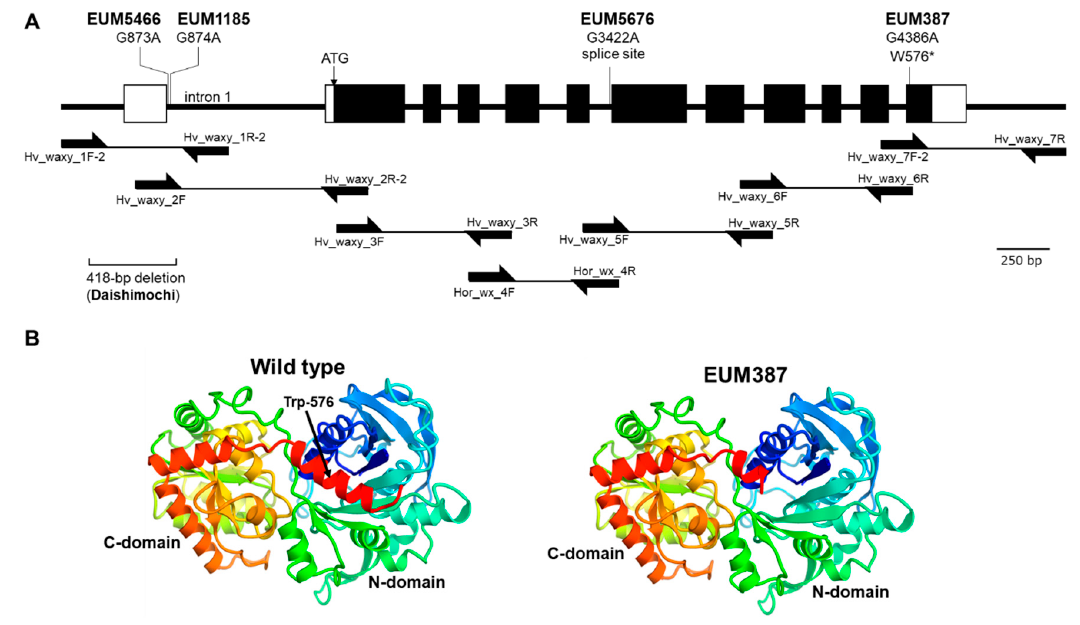
Figure 2. Positions of the identified single nucleotide polymorphisms (SNPs) in the Waxy gene. ( A ) The white and black boxes represent the UTRs and the coding regions, respectively. The nucleotide numbers refer to Domon et al., (2002). The primers and the sequenced PCR amplicons are shown as the arrows and the lines. The positions of SNPs identified from the isolated mutants are shown. EUM5466 and EUM1185 have base substitutions of G873A and G874A in the intron 1, respectively. EUM5676 has a base substitution of G3422A at the 3 ′ splice site of the intron 7. EUM387 has a base substitution of G4386A, which generates a stop codon (*). ‘Daishimochi’ used as a positive control for screening lacks 5 ′ -UTR due to a deletion of 418 bp. ( B ) The barley GBSSI was modeled by Swissmodel using the catalytic domain of rice GBSSIa as a template (PDB ID 3VUF). The C-terminal helix containing Trp-576, which is in close proximity to the N-domain comprising the active center, is lost in EUM387.